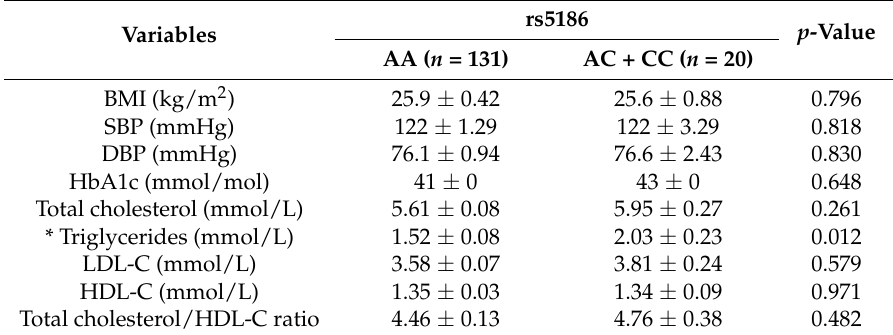
Table 2. Values of CVD metabolic risk factors according to the genotype of the AGTR1 gene rs5186 SNP for Malay subjects ( n = 151).